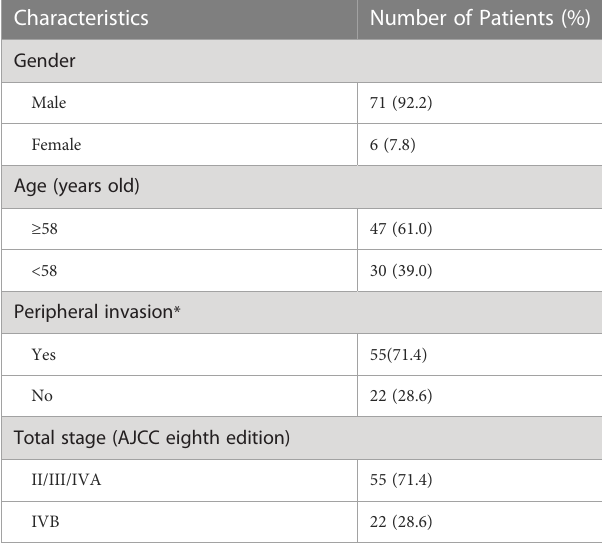
TABLE 1 Clinical characteristics of the 77 patients with locoregionally advanced HPSCC involved in this study.